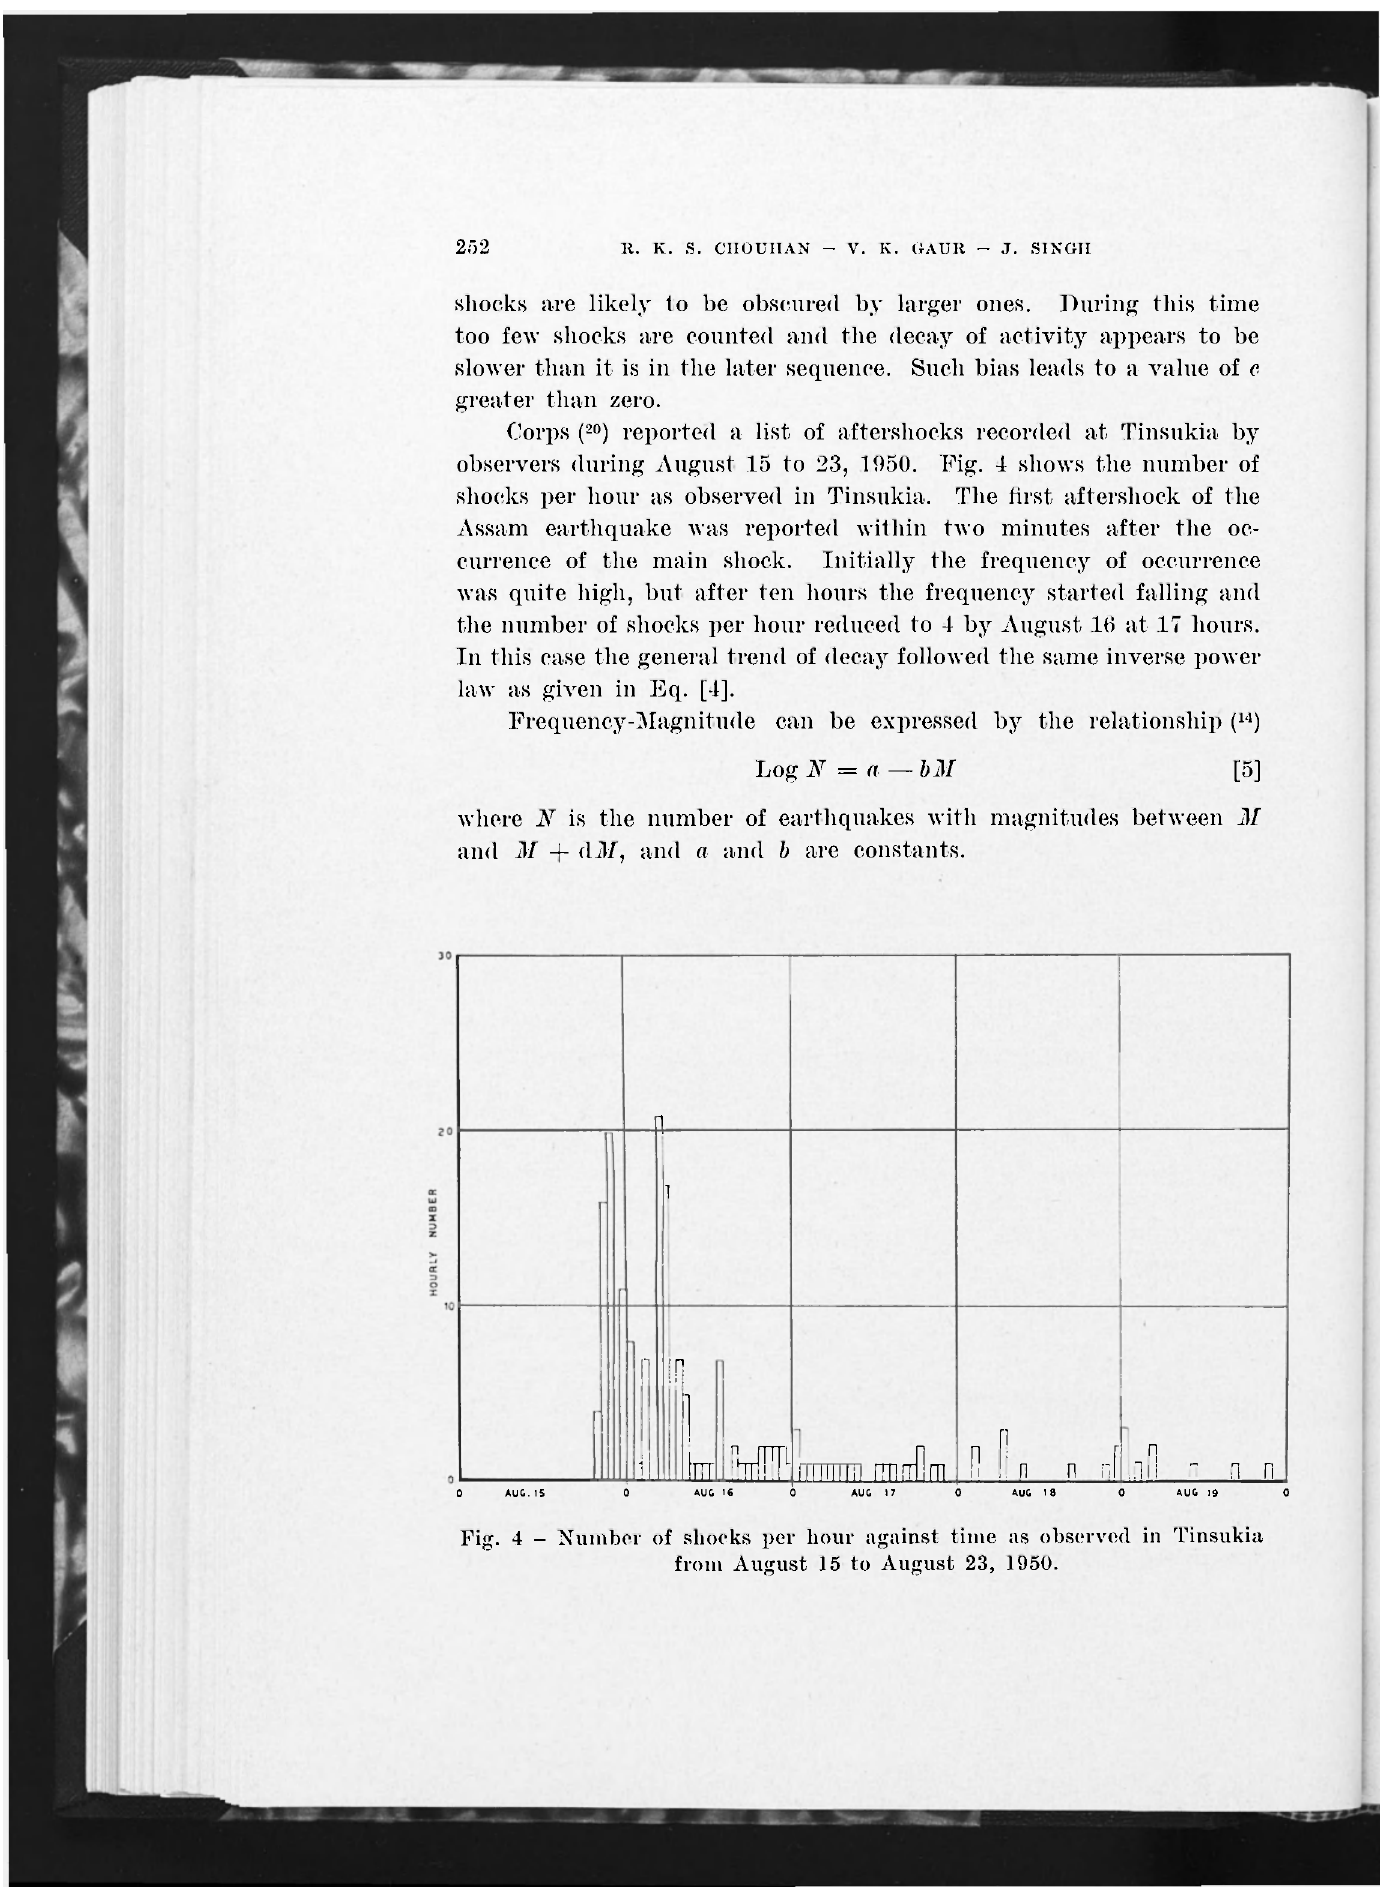
Fig. 4 - Number of shocks per hour against time as observed in Tinsukia from August 15 to August 23,